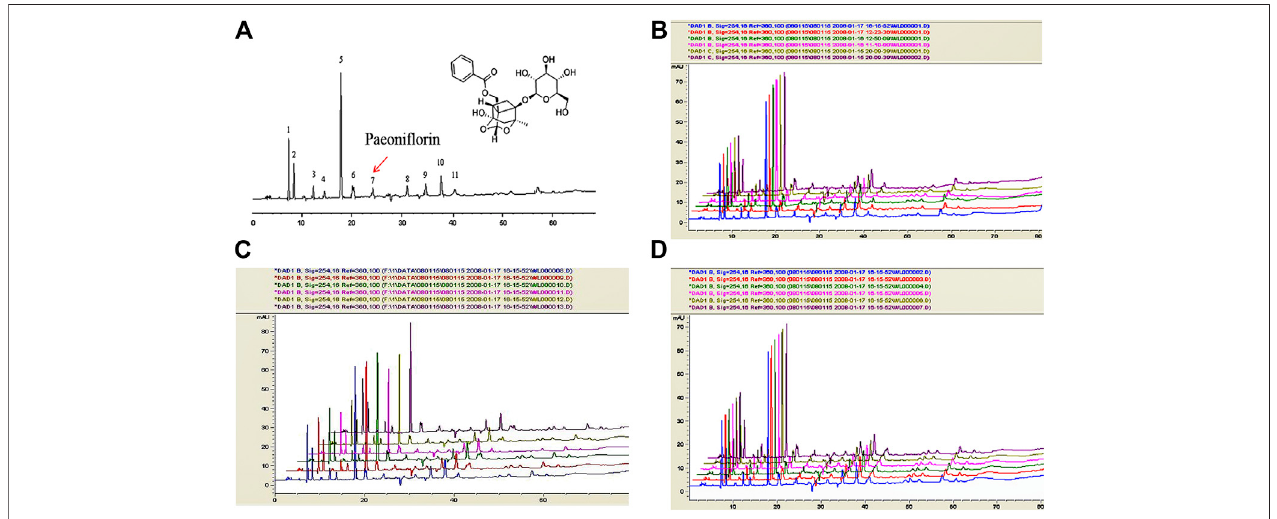
FIGURE 4 | The fi ngerprints of TQHXD for quality control by HPLC. Conditions: column, C18 column (250 × 4.6 mm, 5 μ m); mobile phase, methanol. (A) H 2 O (0.05% V/V phosphoric acid). Flow rate: 1 ml min − 1 ; column temperature: 25 ° C; injection volume: 10 μ L. (A) Representative HPLC chromatogram of TQHXD. 7, Paeoni fl orin. (B – D) The quality control of six batches of TQHXD evaluated by HPLC. The TQHXD solution from six separated raw crude extractions wasanalyzed by the HPLC method. Colors represent different groups of TQHXD test solutions. The X -axis represents acquisition time (Min) and the Y -axis indicates intensity